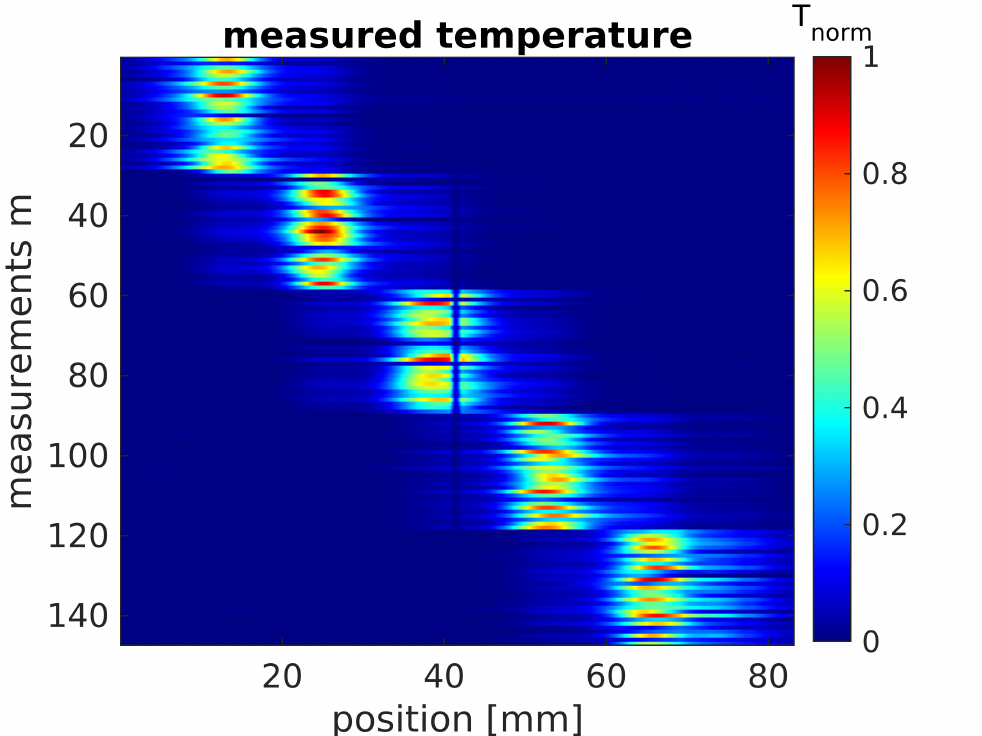
Figure 3. Test data from photothermal structured illumination measurements. To obtain this image, averaging over the vertically arranged pixels as well as applying the MT method (see [30–32]) to eliminate the time dimension is necessary. The blue marker at position = 41mm refers to the marker line on the investigated specimen (Figure